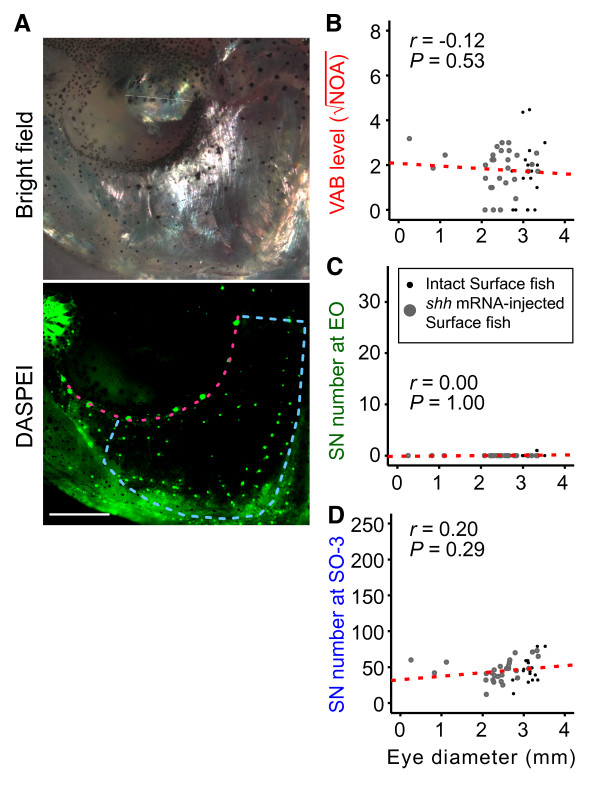
Effects of shh induced eye degeneration on VAB and SN number. (A) Bright field image (upper) and DASPEI-stained neuromasts (lower) in two-year-old adults that developed from shhA-mRNA injected surface fish embryos. The red dashes indicate the line of suborbital canal neuromasts in the head lateral line and the areas enclosed by the blue dashed lines indicate the SO-3 region. Scale bar in (lower panel of A) is 1.0 mm. (B-D) Regression analysis showing the relationship between eye diameter and (B) VAB level, (C) EO SN number and (D) SO-3 SN number in shhA-mRNA injected surface fish (gray dots) compared to uninjected surface fish (black dots). Linear regression line is shown in red. Eye degeneration did not result in the appearance of SN in the EO or increase VAB level in shh-overexpressed surface fish.